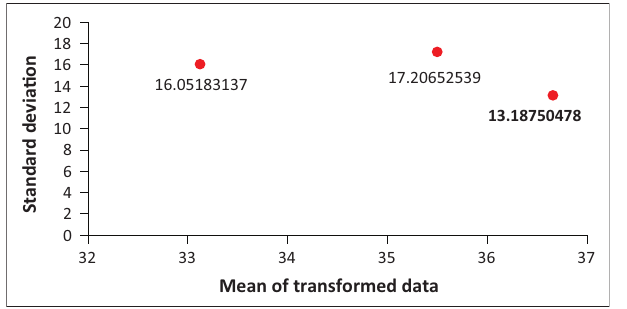
Mean of transformed data FIGURE 1: Bartlett’s test for homogeneity of variances. TABLE 4: Bartlett’s test for homogeneity of variances. Variables